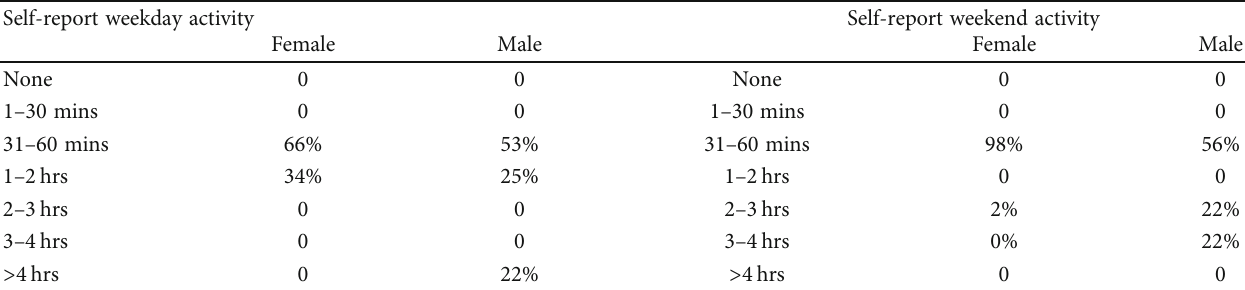
Table 6: Comparison between male and female self-reported weekday and weekend MVPA duration (minutes). Self-report weekday